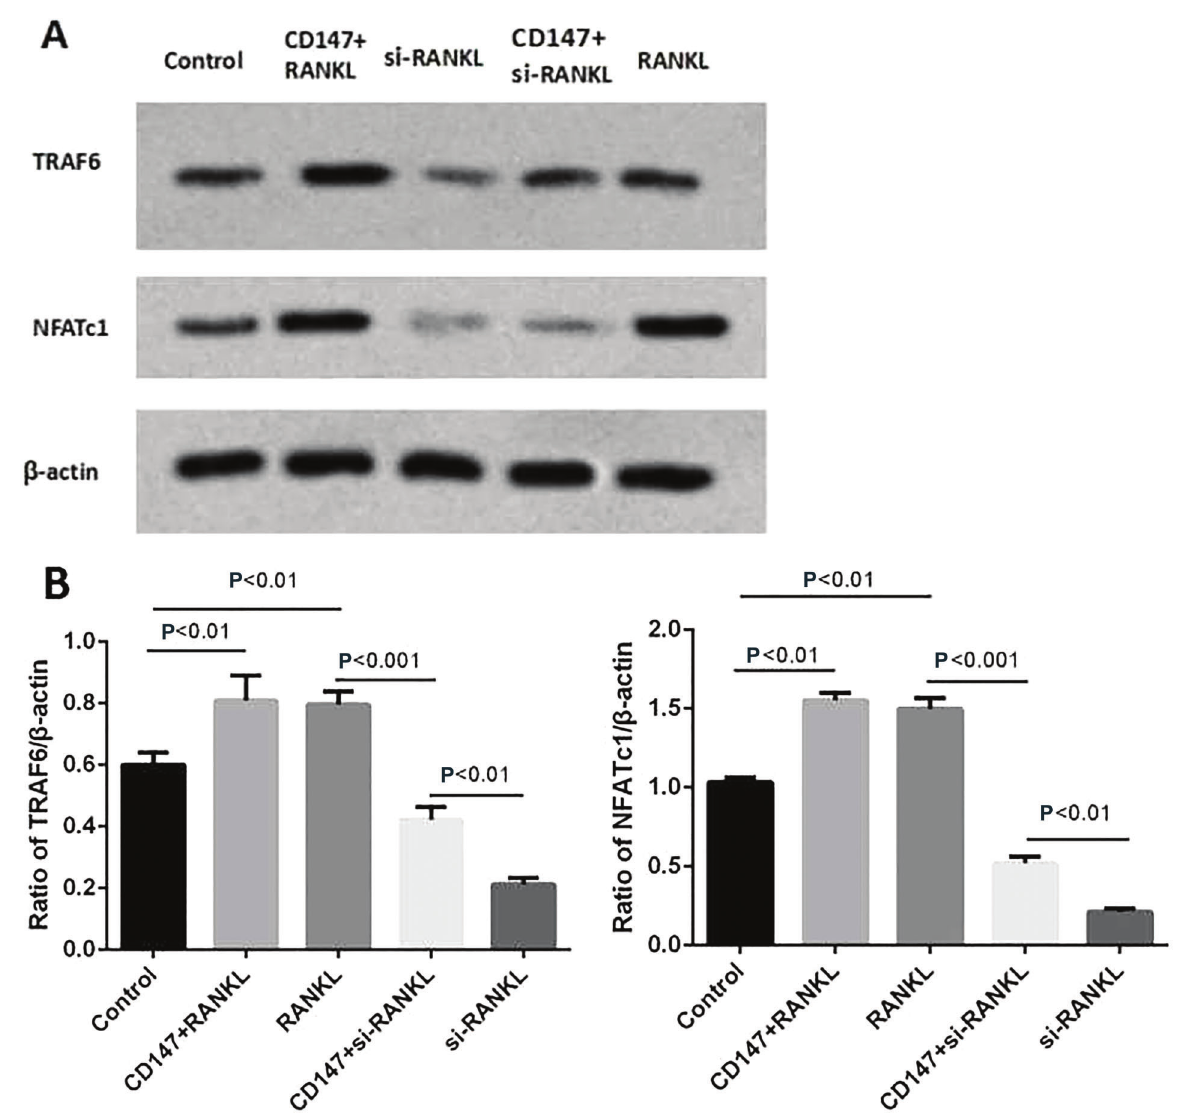
Figure 3. Western blot analysis of the effects of CD147 gene expression on the key factors in the RANKL signaling pathway. A , Western blot analyses of TNF receptor-associated factor-6 (TRAF6) and nuclear factor of activated T-cells cytoplasmic 1 (NFATc1e). B , Ratio of TRAF6 and NFATc1 to b -actin. Data are reported as means ± SD and compared with the t -test. RANKL: receptor activator of NF- k B